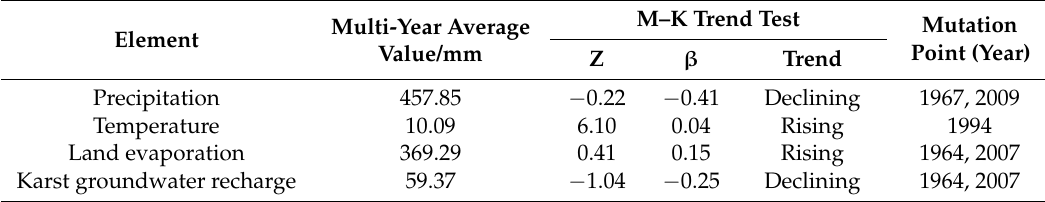
Table 2. The trend and abrupt change test of the annual average precipitation, temperature, land evaporation, and karst groundwater